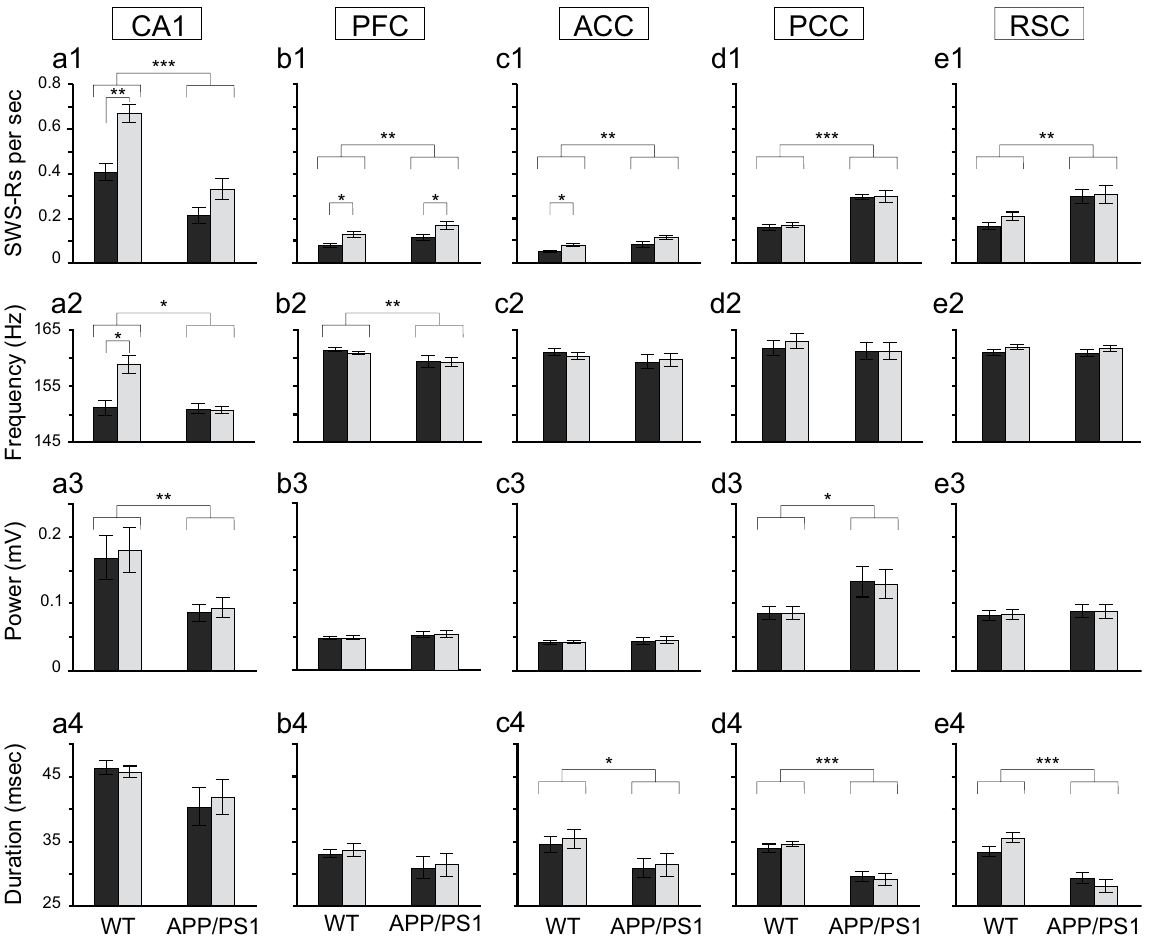
Figure 3. Impairment of hippocampal ripples and enhanced expression of cortical ripples during SWS in APP-PS1 mice. ( a1-4) . CA1 ripples in APP-PS1 group expressed lower occurrence rate (APP/PS1: N =